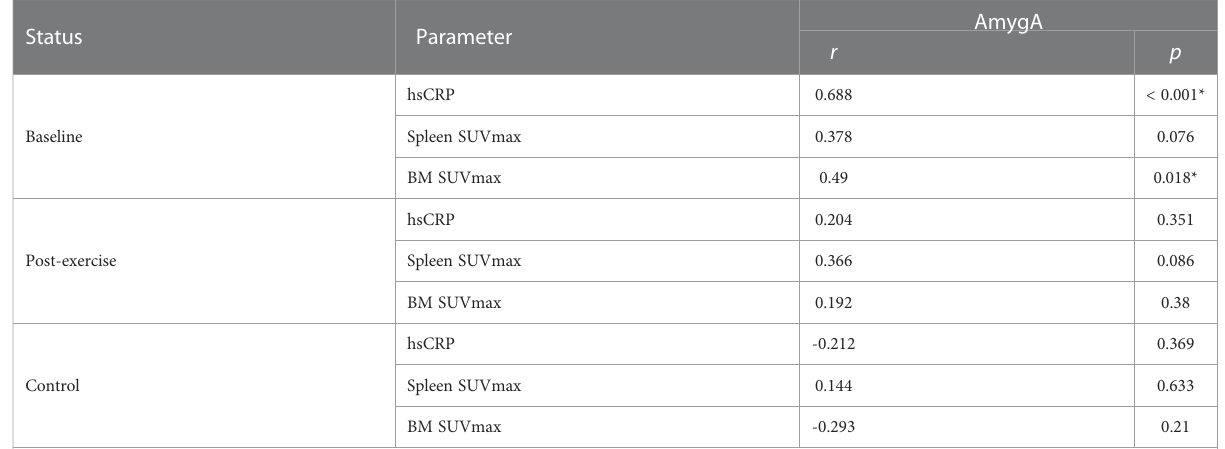
TABLE 2 Correlation analysis between AmygA and surrogate markers for systemic in fl